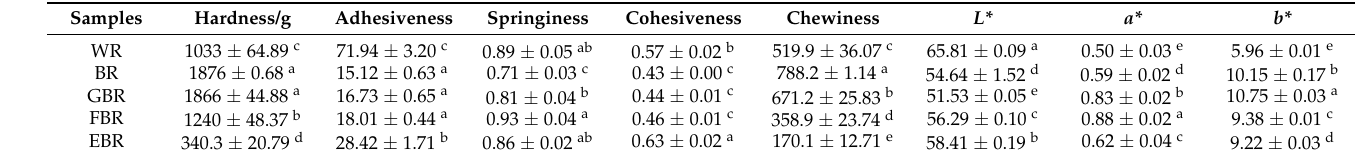
Table 4. Texture properties and colors of different brown rice